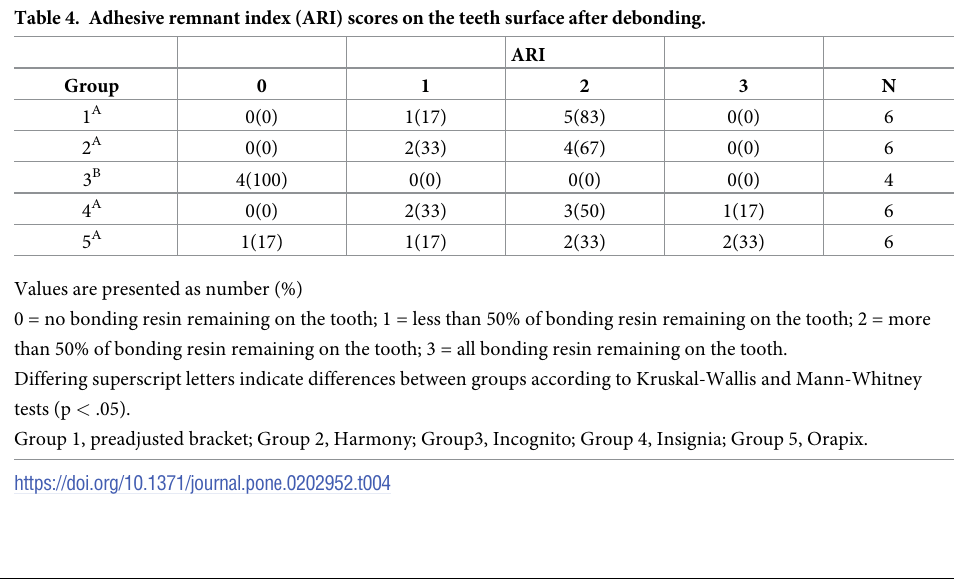
Control, preadjusted bracket; Lingual, Incognito and Harmony; Labial, Insignia and Orapix. The different superscripts indicated the statistic difference at p < 0.05